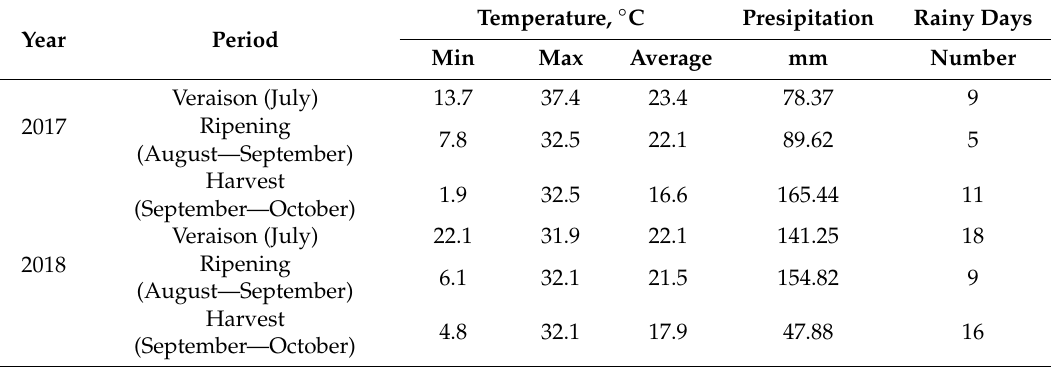
Table 5. Agro-meteorological conditions for the investigated periods and region—Village of Mogilovo, Chirpan